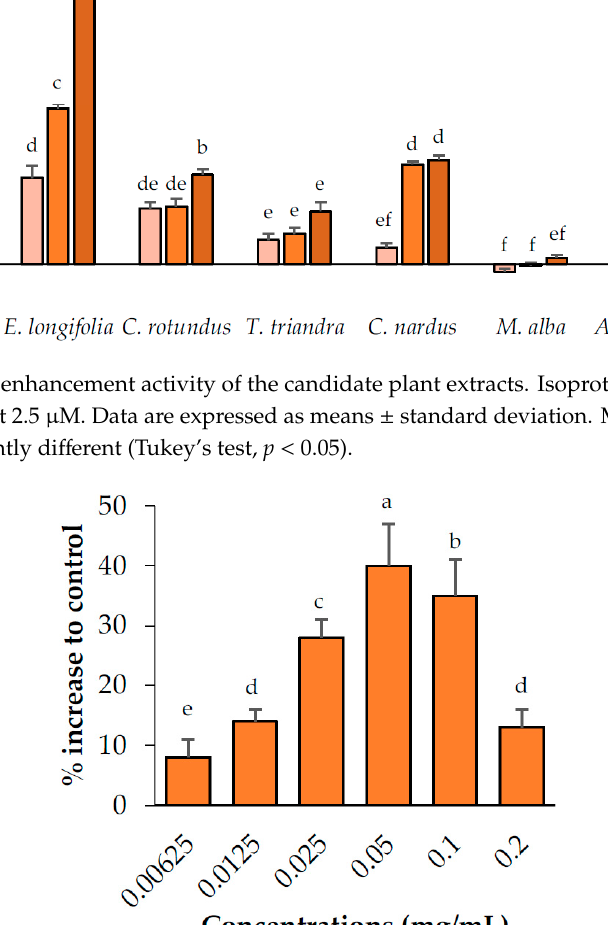
Figure 3. Lipolysis enhancement activity of the Acacia concinna extract. Data are expressed as means ± standard deviation. Means with different letters are significantly different (Tukey’s test, p < 0.05).